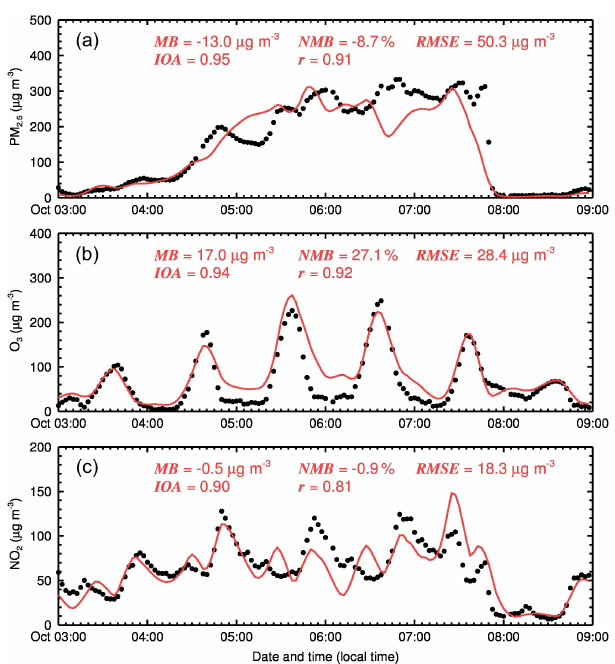
Figure 9. Diurnal variations in the modeled (red curves) and ob- served (black dots) surface submicron (a) POA and (b) SOA con- centrations at the NCNT station, and (c) EC concentration in PM 2 . 5 at the CRAES station in Beijing from 3 to 8 October